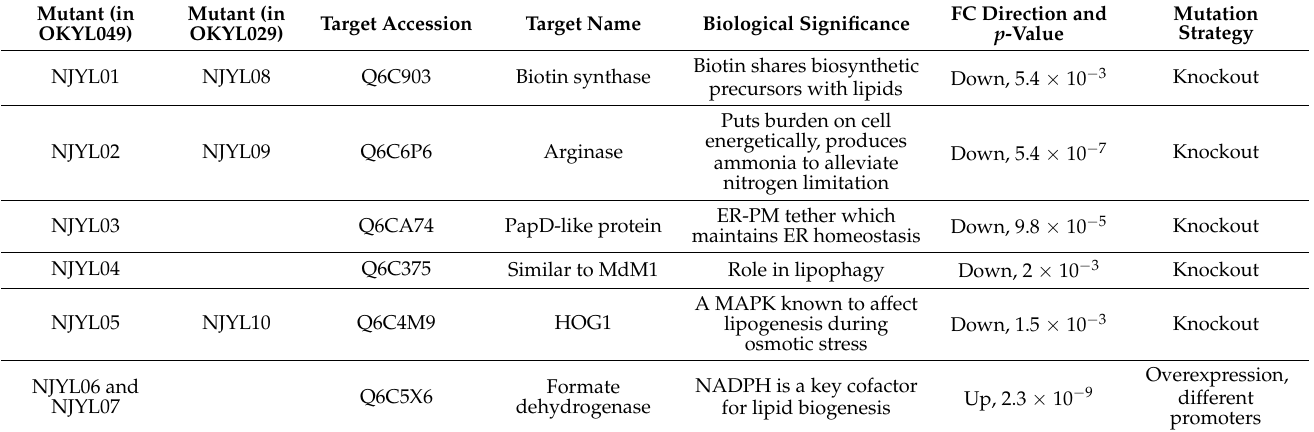
Table 3. Selected mutation targets for experimental analysis of lipid accumulation in Y. lipolytica